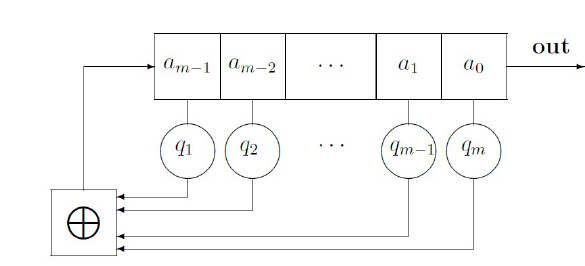
Figure 1. A Linear Feedback Shift Register of Length m .